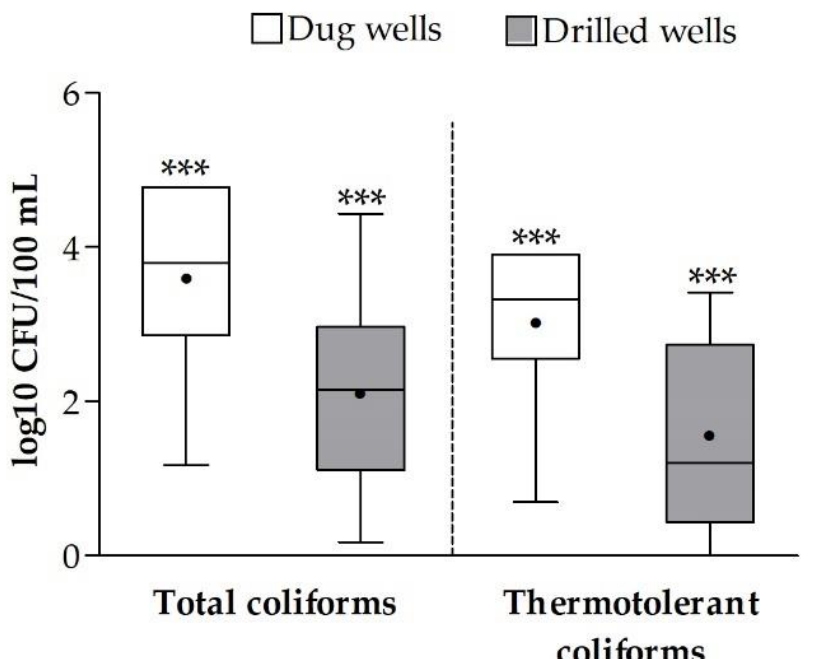
Figure 2. Box plot (min/max, lower/upper quartile, median, average) of CFU/100 mL of total and thermotolerant coliforms in the wells in Porto Velho (RO). Groups with significant differences are indicated by asterisks (***).